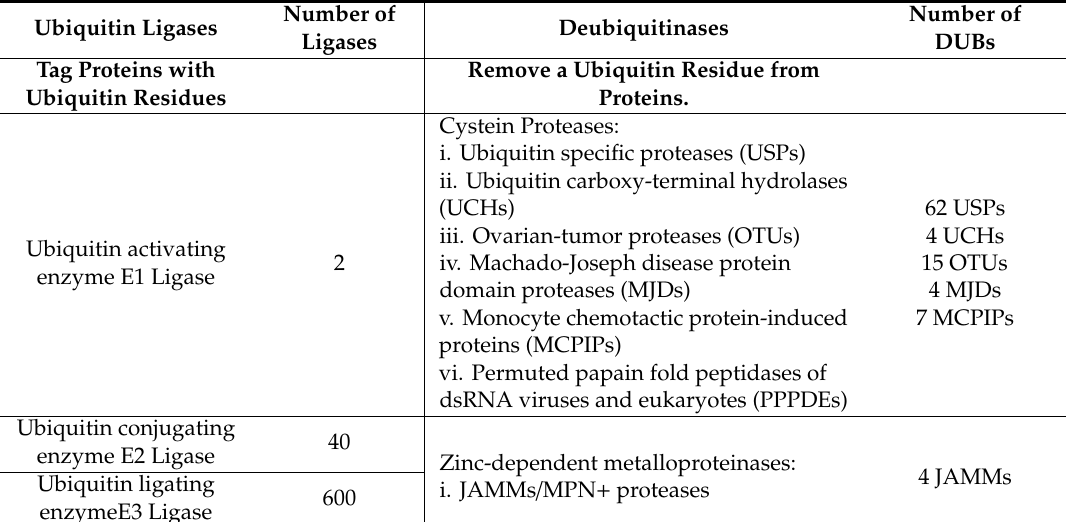
Table 1. Ubiquitinases and